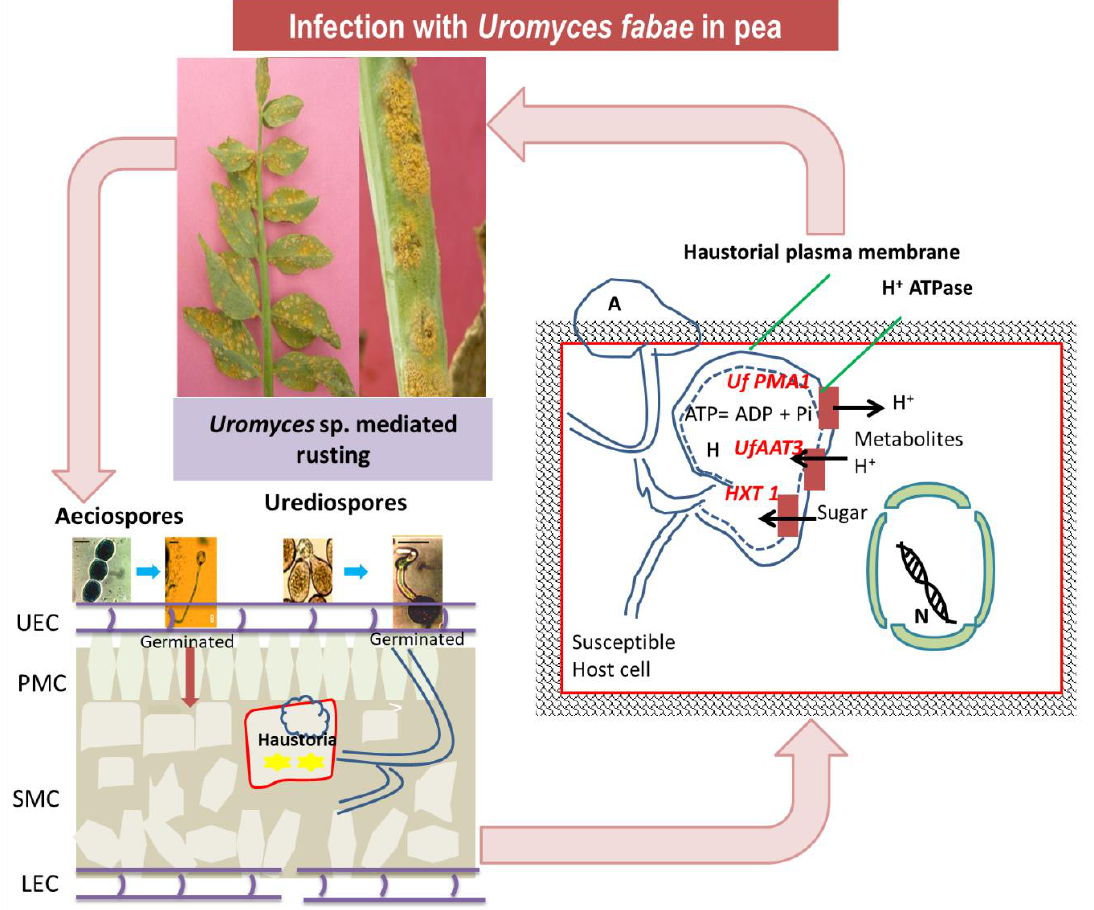
Figure 5. Schematic view of suppression of host defense by Uromyces viciae-fabae . Here, UEC: Upper epidermis cells; PMC: Primary mesophyll cells; SMC: Secondary mesophyll cells; LEC: Lower epidermis cells; A: Aprresorium; H: Haustoria; N: Nucleus.